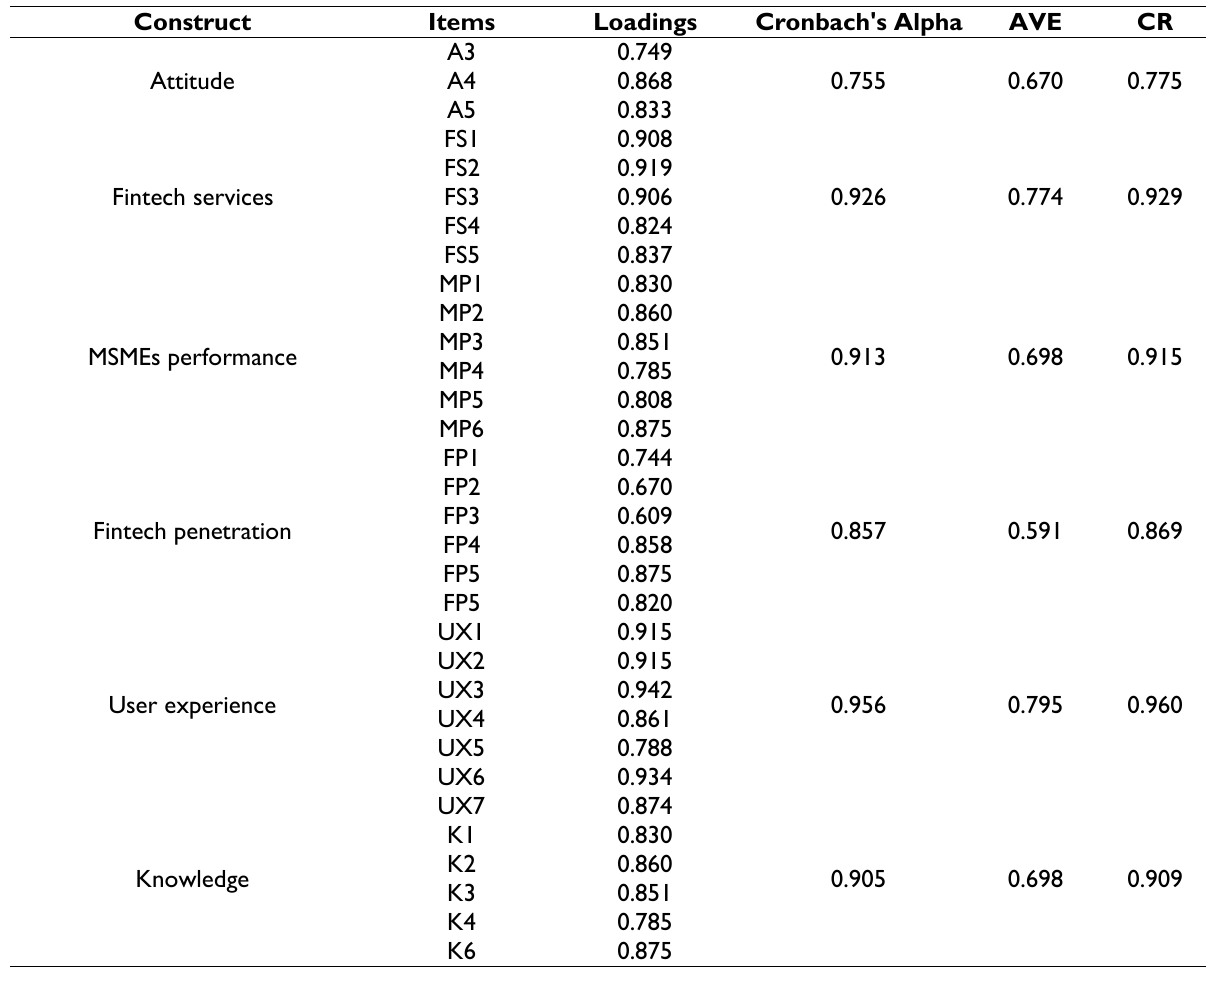
Table 3. Measurement Model